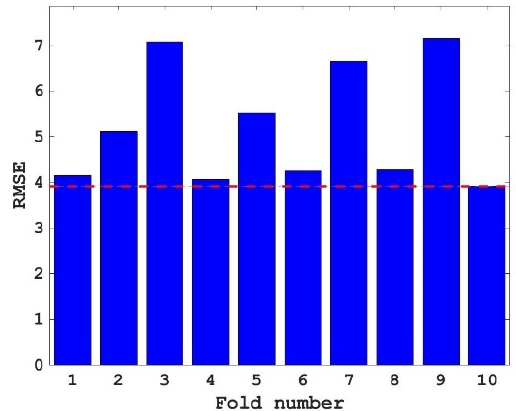
Figure 6. RMSE values of different folds.